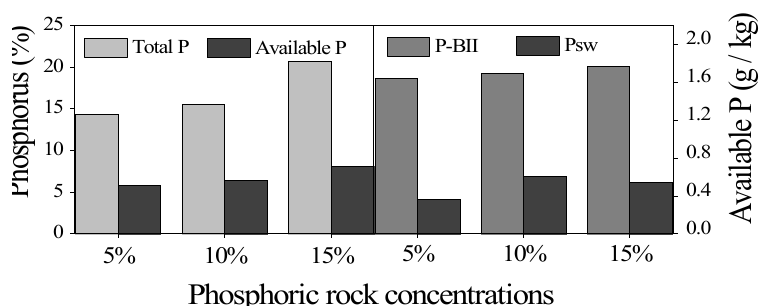
Fig. 4 Variation of total P, assimilable P, and water-soluble P at different PR